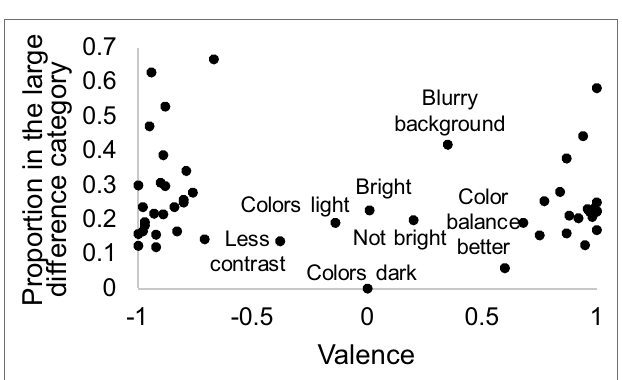
FIGURE 7 | Subjective attributes according to their valence and proportion in the large difference category (for calculation of valence, see section “Data Analysis”). Most attributes align to either end of the valence dimensions. The named attributes in the middle of the valence dimension represent the small minority of all attributes, are typically mentioned in pairs with small difference, and have rather neutral meanings. Location of other attributes in these two dimensions is reported in Appendix A